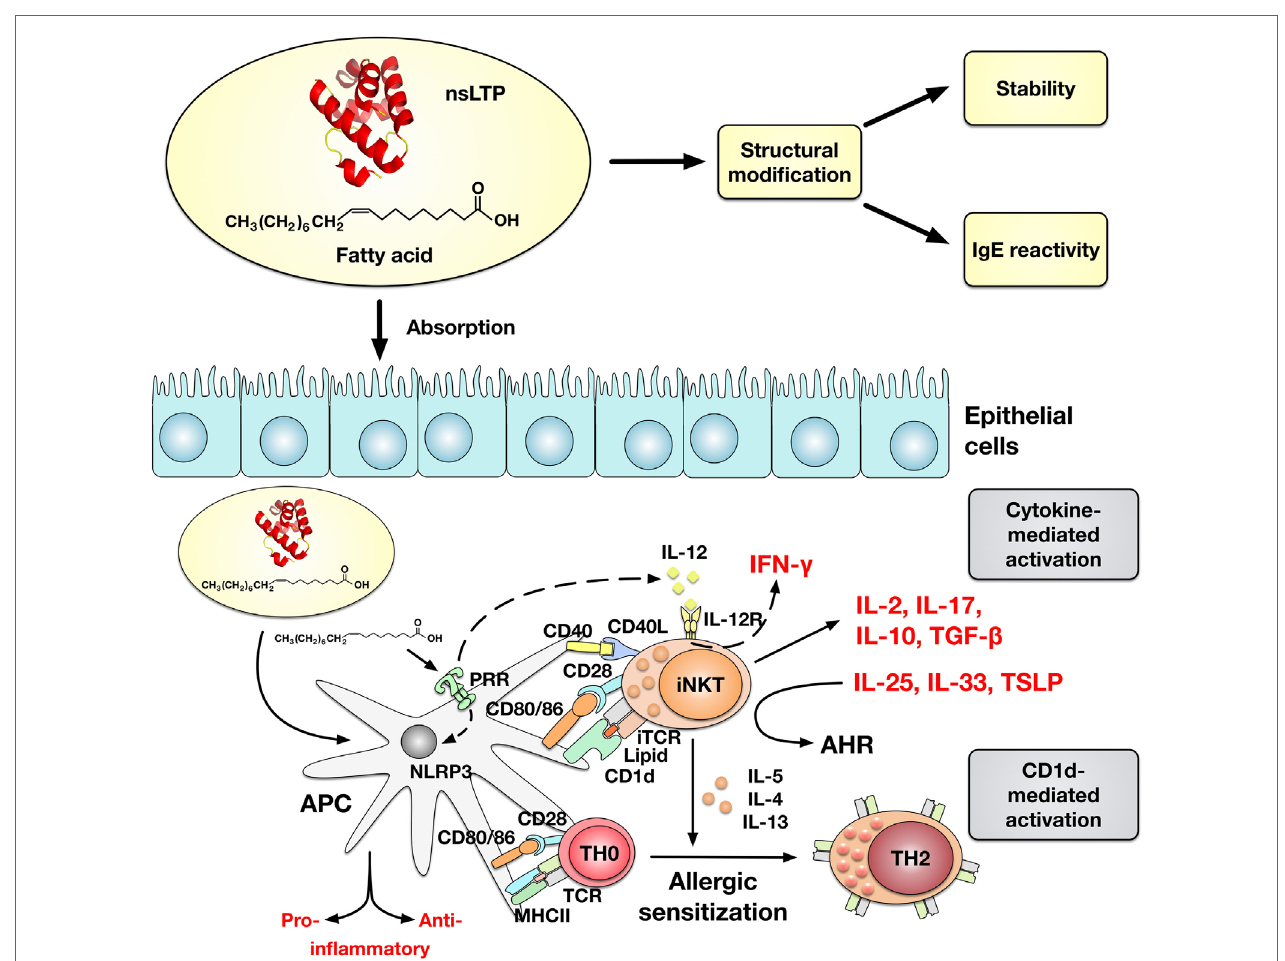
FiGURe 1 | Impact of lipid binding to non-specific lipid-transfer proteins (nsLTPs) on the IgE-reactivity and allergic sensitization. Lipid binding can affect gastrointestinal stability and IgE-reactivity of nsLTPs. Whether the altered IgE-reactivity upon lipid binding is accompanied by structural modification of the protein remains to be elucidated. Moreover, lipids can induce a cytokine- or CD1d-mediated activation of invariant natural killer T (iNKT) cells. Microbial lipids are sensed by pathogen recognition receptors (PRRs) on APCs (DC and M ϕ ) and induce an IL-12-mediated activation of iNKT cells which is accompanied by INF- γ secretion. Other lipid ligands which are administrated to APCs in a complex with nsLTPs are internalized, loaded on CD1d, and presented to the TCR (V α 24/J α 18 + in humans) on iNKT cells. The CD1d-restricted activation of iNKT cells by nsLTP–lipid complexes is suggested to promote the allergic sensitization by inducing T H 2-cytokine secretion. In line with this, iNKT cells can promote airway hyperreactivity (AHR) in the presence of IL-25, IL-33, and TSLP. However, activated iNKT cells can display a T H 1- (INF- γ ) and T H 2- (IL-5, IL-4, and IL-13) like plasticity and lipids can either promote or attenuate NLRP3 inflammasome activity and induce both pro- or anti-inflammatory